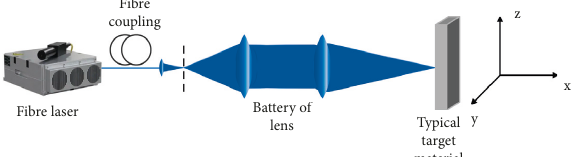
Figure 4: Schematic diagram of the fiber optic infrared device system for defects.